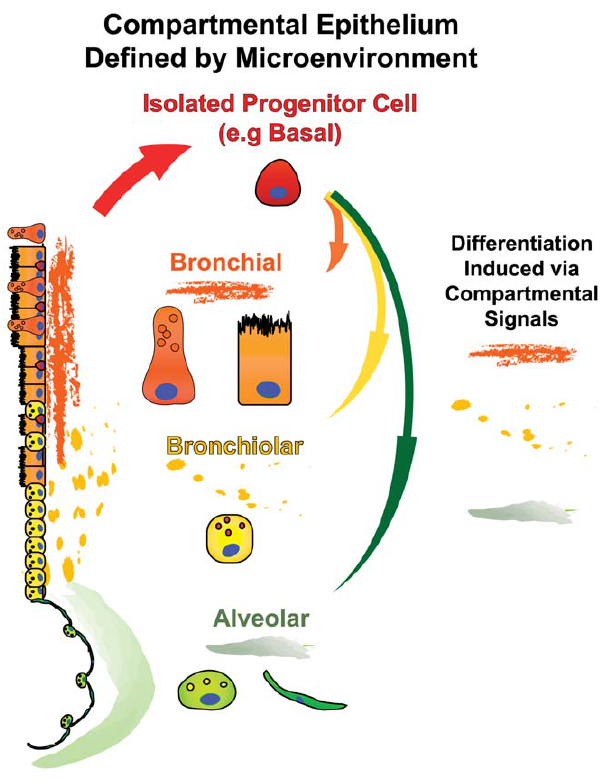
Figure 5. Differentiation of Multipotent Progenitors of Adult Human Lung Dictated by the Microenvironment. Cues provided by the microenvironment encompassing each of the anatomical compartments of the adult human lung provide cues that direct the differentiation of activated multipotent progenitor cells in vivo . Differentiation of isolated progenitor cells in vitro is thus largely influenced by the extrinsic signals provided.